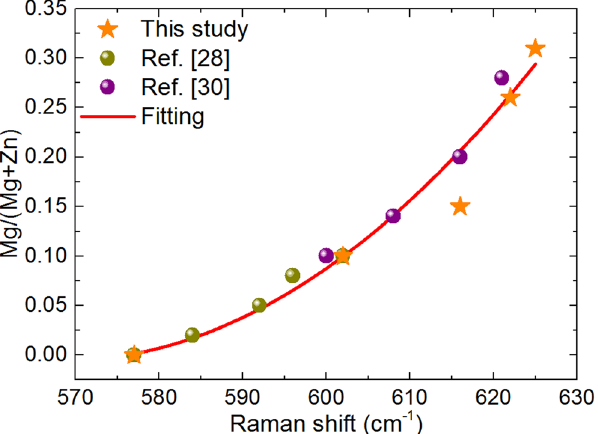
Figure 4. Mg/(Mg + Zn) relative content versus frequency of the main LO Raman peak. Starts: experimental data from layers series (i). Circles: data reported from references 28, 30 . Full line shows the fitting of the data according to Equation